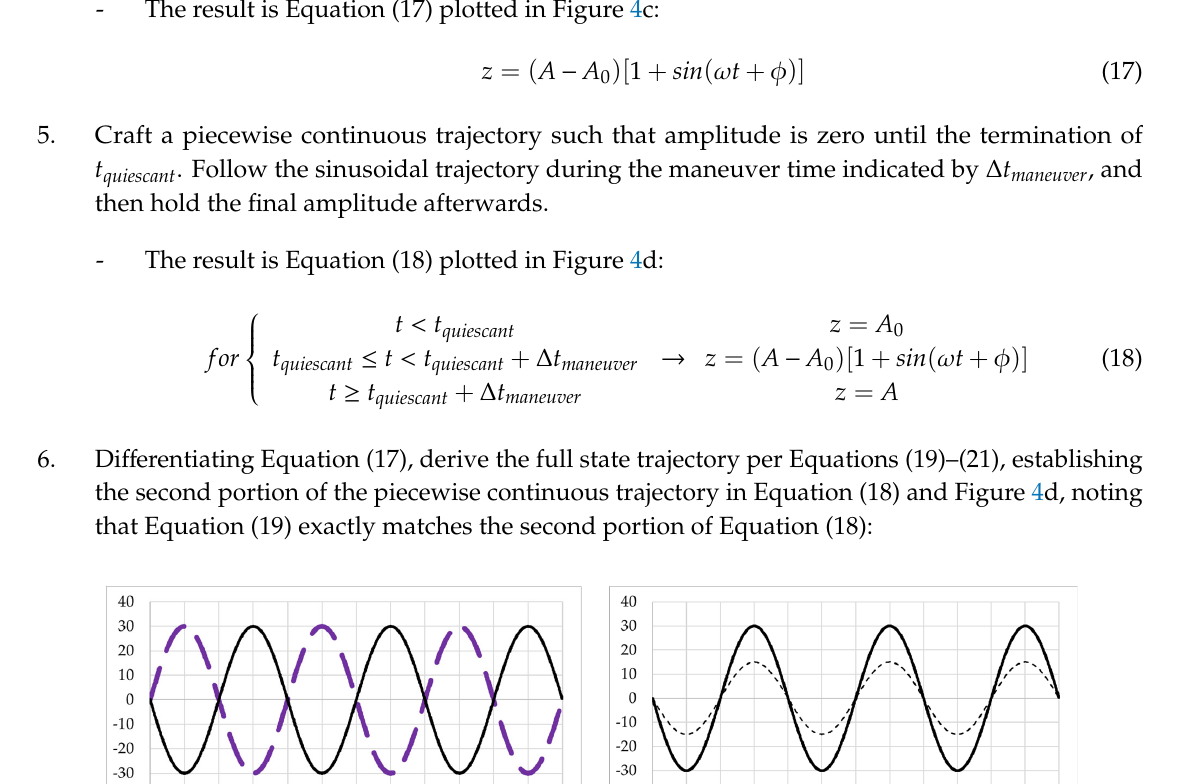
4. Amplitude-shift the curve up for smooth initiation at arbitrary starting position used here by adding A 0 .